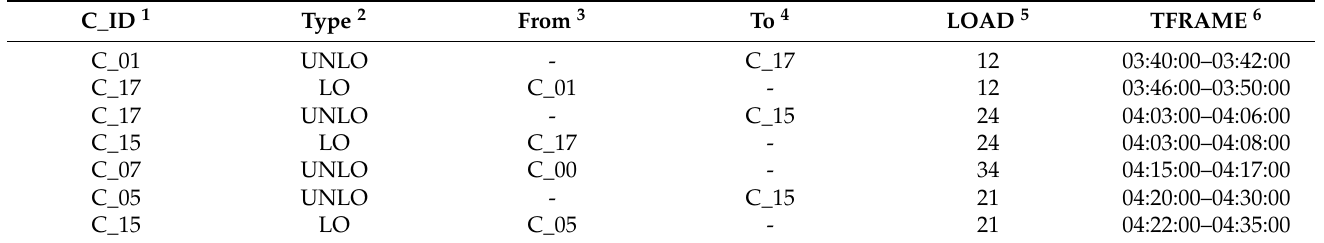
Table 2. Real-time-generated supply demands of the in-plant supply optimization